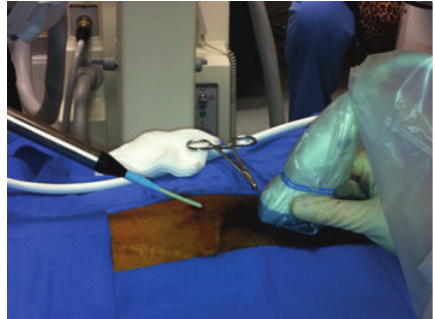
Figure 2: The cryoprobe was inserted via a 12-gauge angiocatheter introducer proximal to the skin graft site of the left lower extremity. The ultrasound probe is being utilized to provide an in-plane view of the cryoprobe and ice ball location during cryoneurolysis